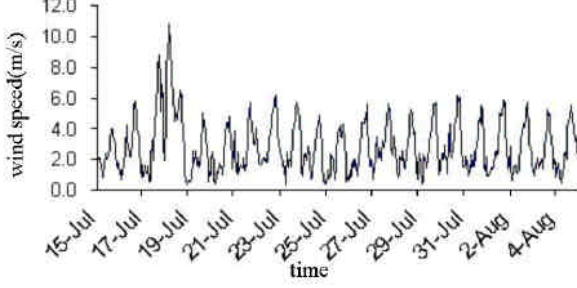
Figure3. Hourly time series of wind speed (U 10 ) against time (24h interval) Fig. 3. Hourly time series of wind speed ( U 10 ) against time (24-h